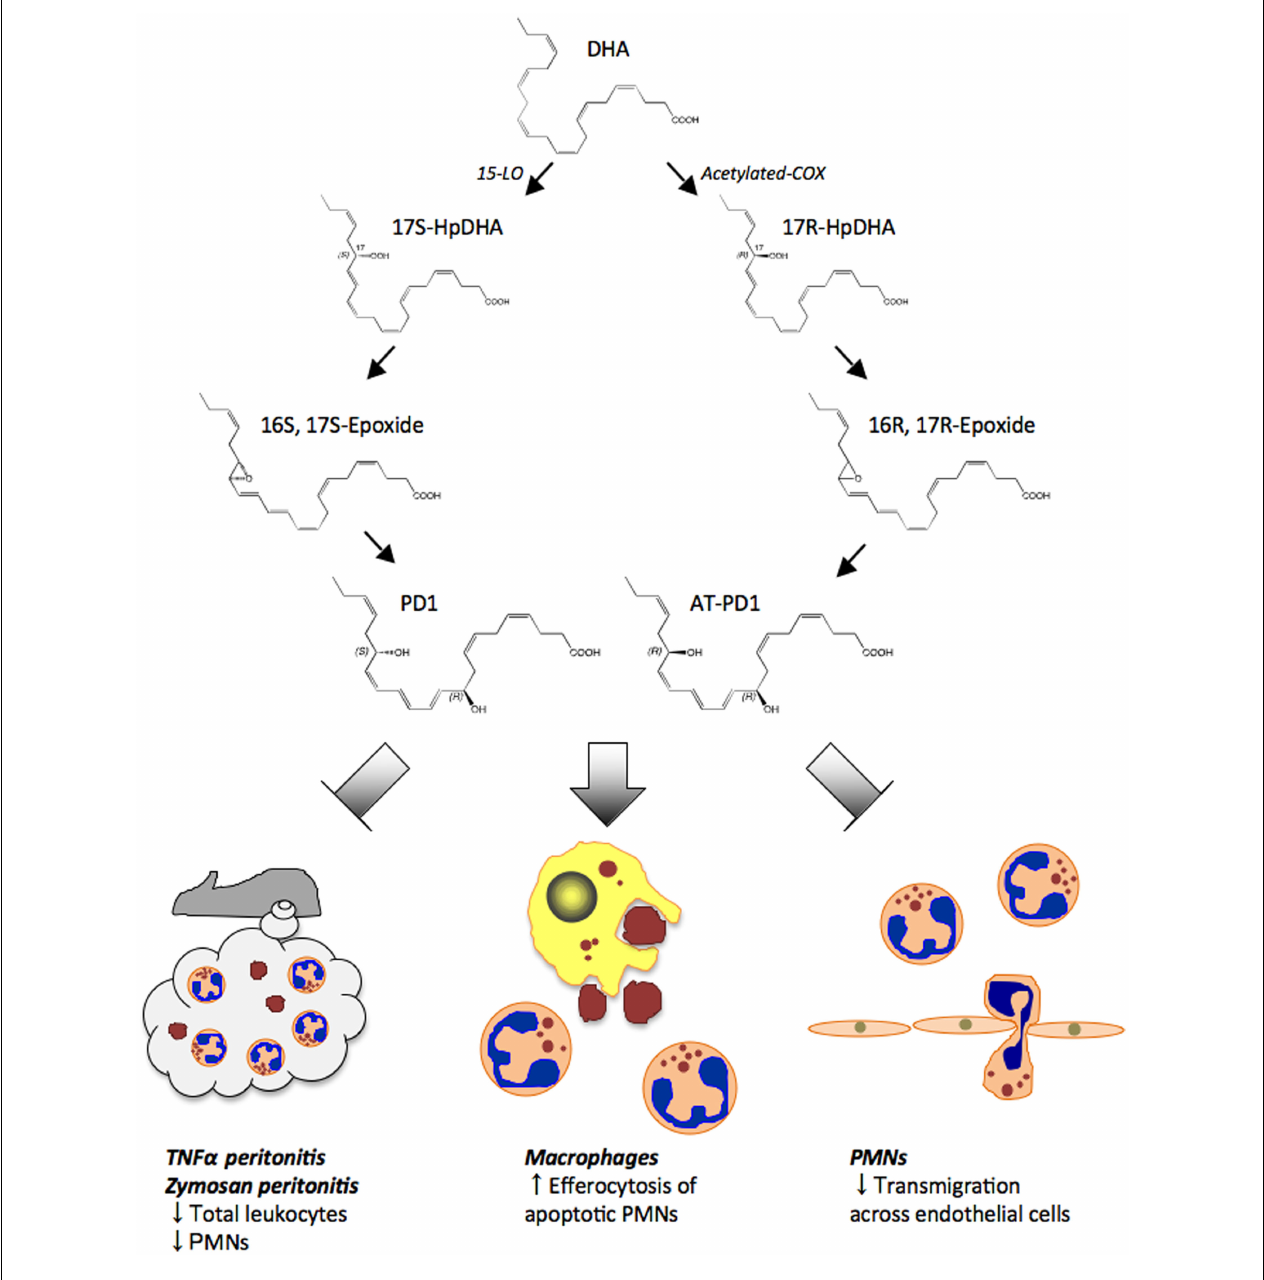
epoxide intermediate. Both PD1 and AT-PD1 reduce leukocytes and PMN infiltration in peritonitis stimulated by eitherTNF- α or zymosan A. PD1 and AT-PD1 each enhance human macrophage efferocytosis of apoptotic human PMNs and limit human PMN transmigration across human endothelial cells, the defining pro-resolving